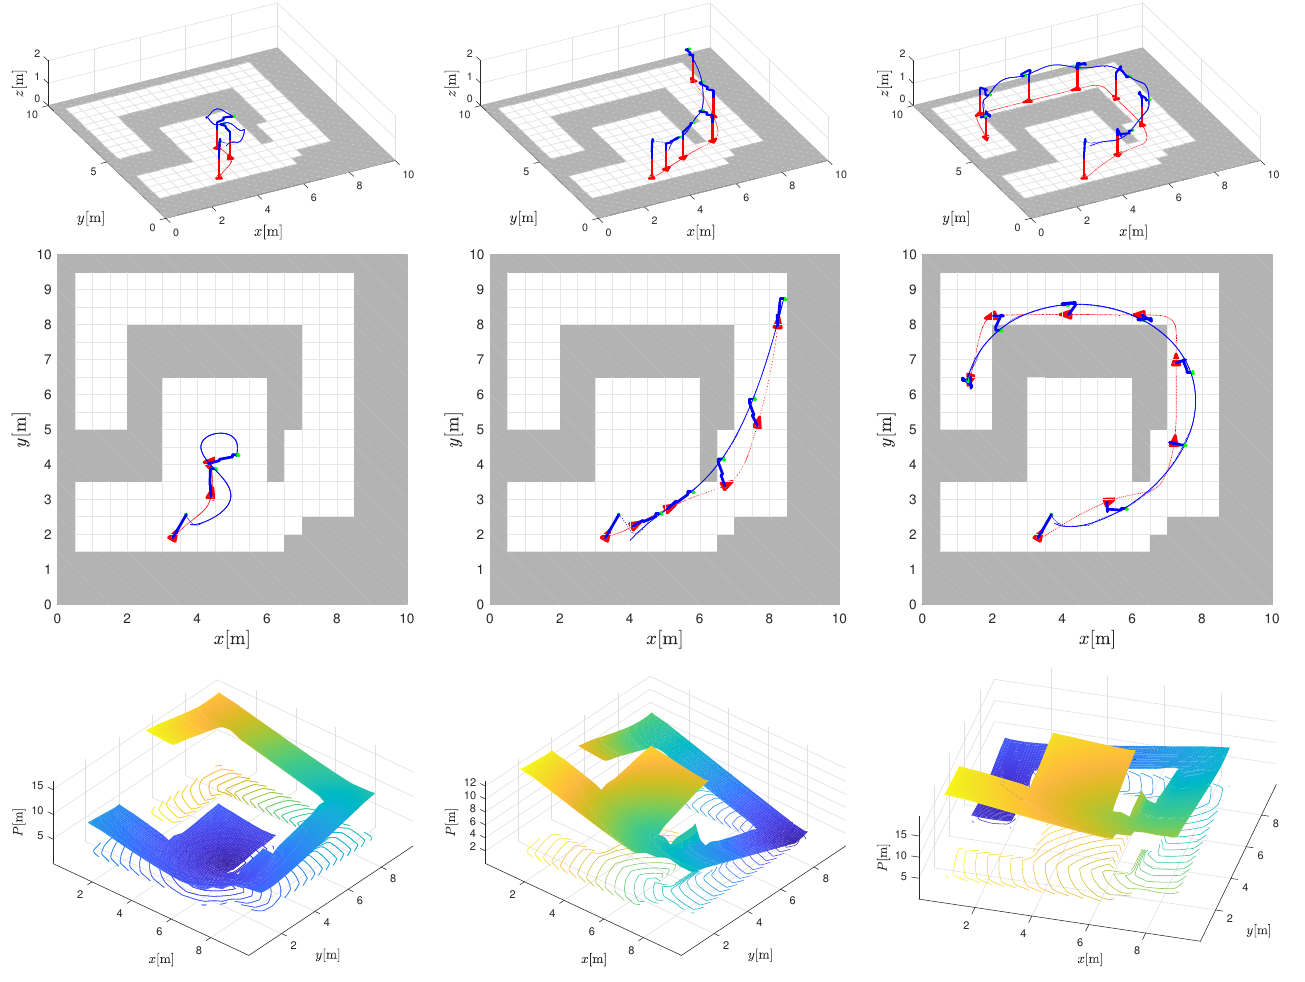
Figure 5. Trajectory tracking: three scenarios (shown in columns) of joint arm trajectory tracking and the base potential field navigation. The first and second rows show the reference trajectory of the arm (solid blue line), the obtained motion (dotted blue line), and the base trajectory (dotted red line). The third row shows the calculated potential navigation with the displayed contours of the same